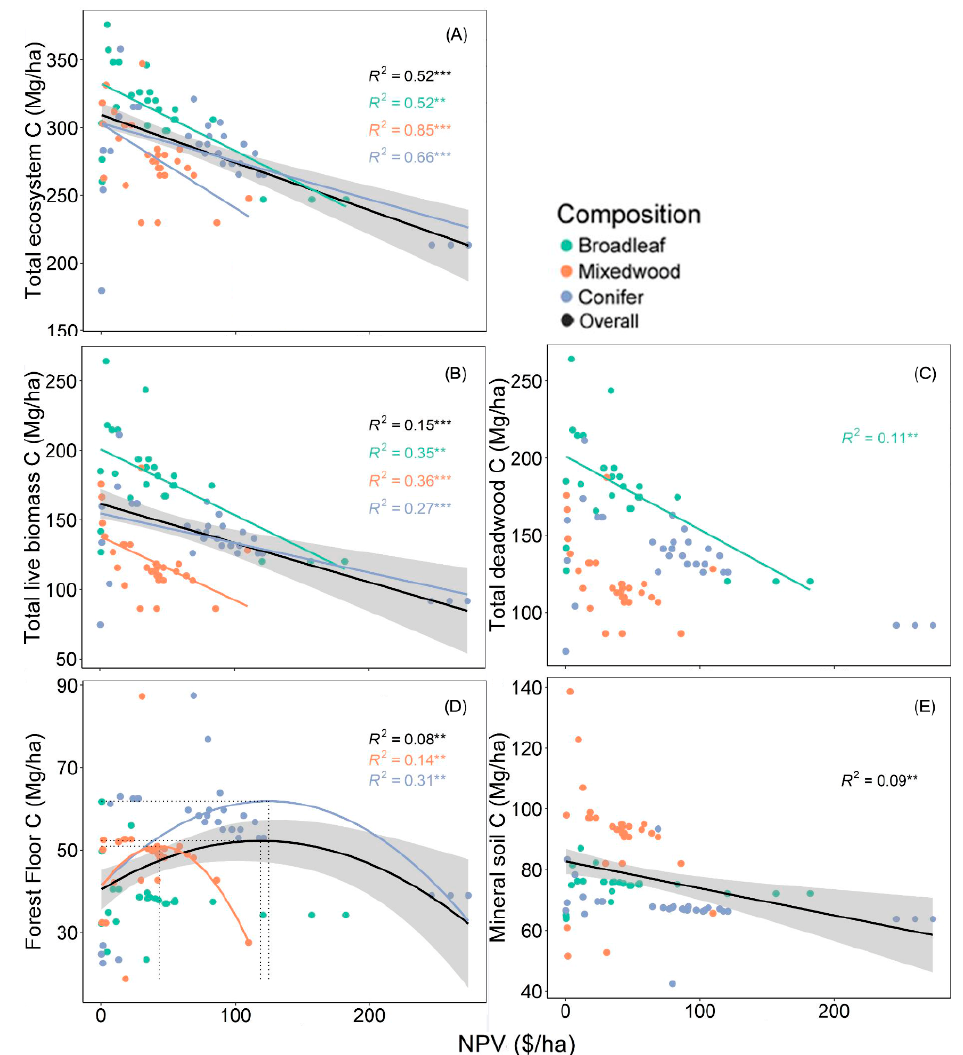
Figure 2. Trends in ( A ) total ecosystem C, ( B ) total live biomass C, ( C ) total deadwood C, ( D ) forest floor C and ( E ) mineral soil C with net present value (NPV) and in relation to overstorey compositions and rotation ages above 50 years. Adjusted R 2 values are based on linear or polynomial regressions. Black lines with the shaded region are estimated mean and 95% confidence intervals. Significant differences ( α = 0.05). Significant codes ( p -value): 0 ‘***’, 0.001 ‘**’.